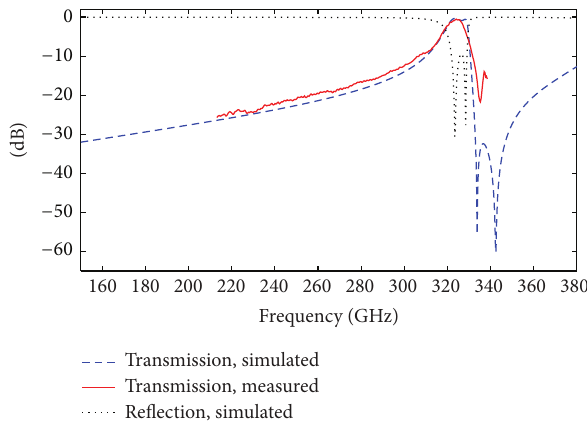
Figure 8: Transmission and reflection performance of proposed FSS.